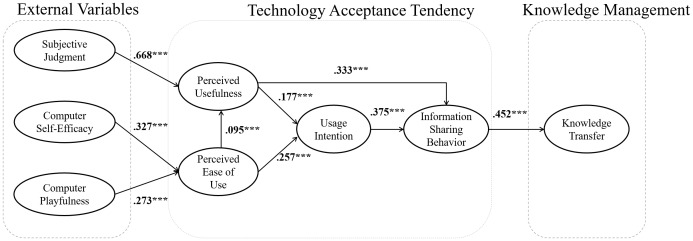
Path analysis results based on all valid samples (n = 779).